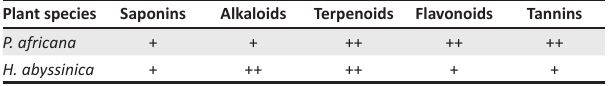
TABLE 1: Phytochemical screening of crude extracts of Prunus africana and Harrisonia abyssinica.